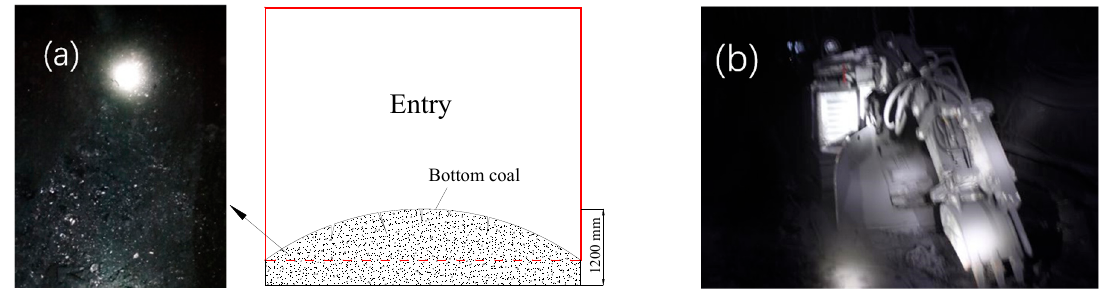
Figure 16. Bottom coal recovery site. ( a ) Fracture of coal body in the excavation section; ( b ) bottom coal recovery by the mining excavator.